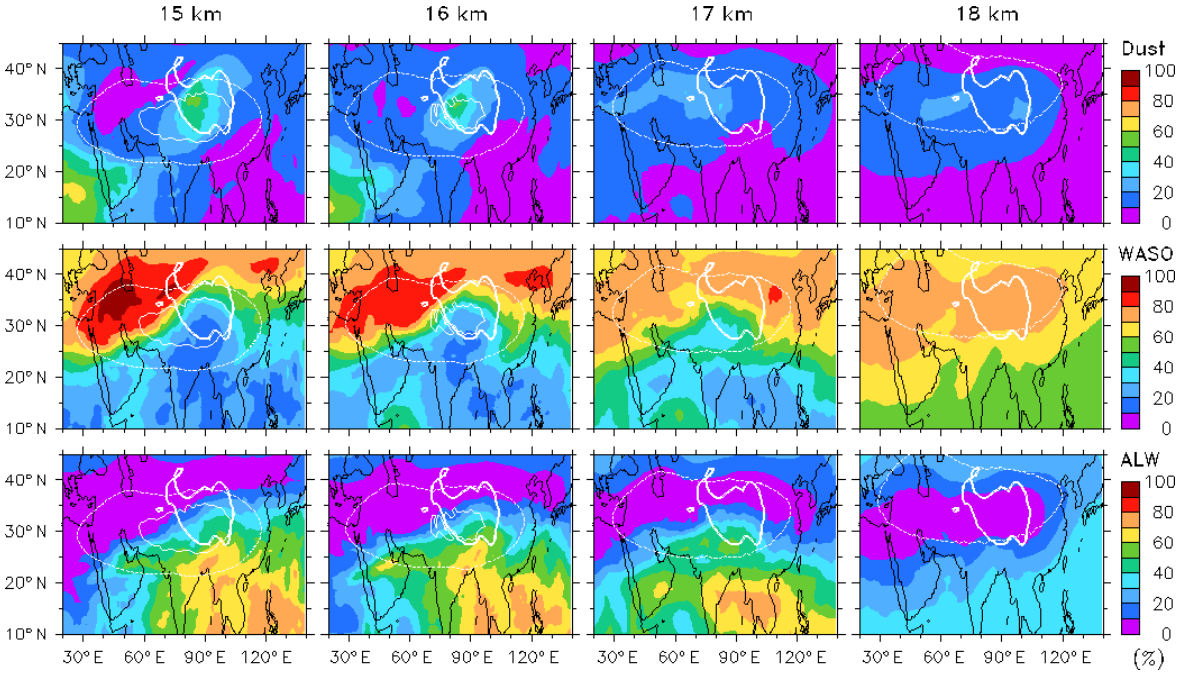
Figure 7. Same as Fig. 6 but for the year